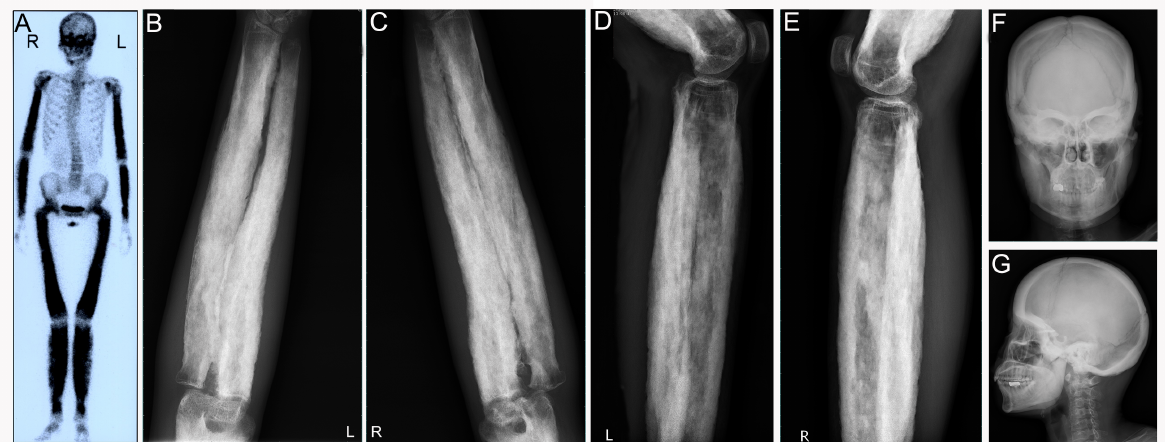
Figure 5. Patient 4: ( A ) 99m Tc-MDP bone scan demonstrated symmetric uptake of radiotracer mainly in the skull, upper and lower extremities. Radiographs of both upper limbs ( B , C ) and lower limbs ( D , E ) revealed thickened cortices and narrowed medullary space. ( F , G ) X-ray films of anteroposterior position and lateral position showed the skull of the patient was thickened as